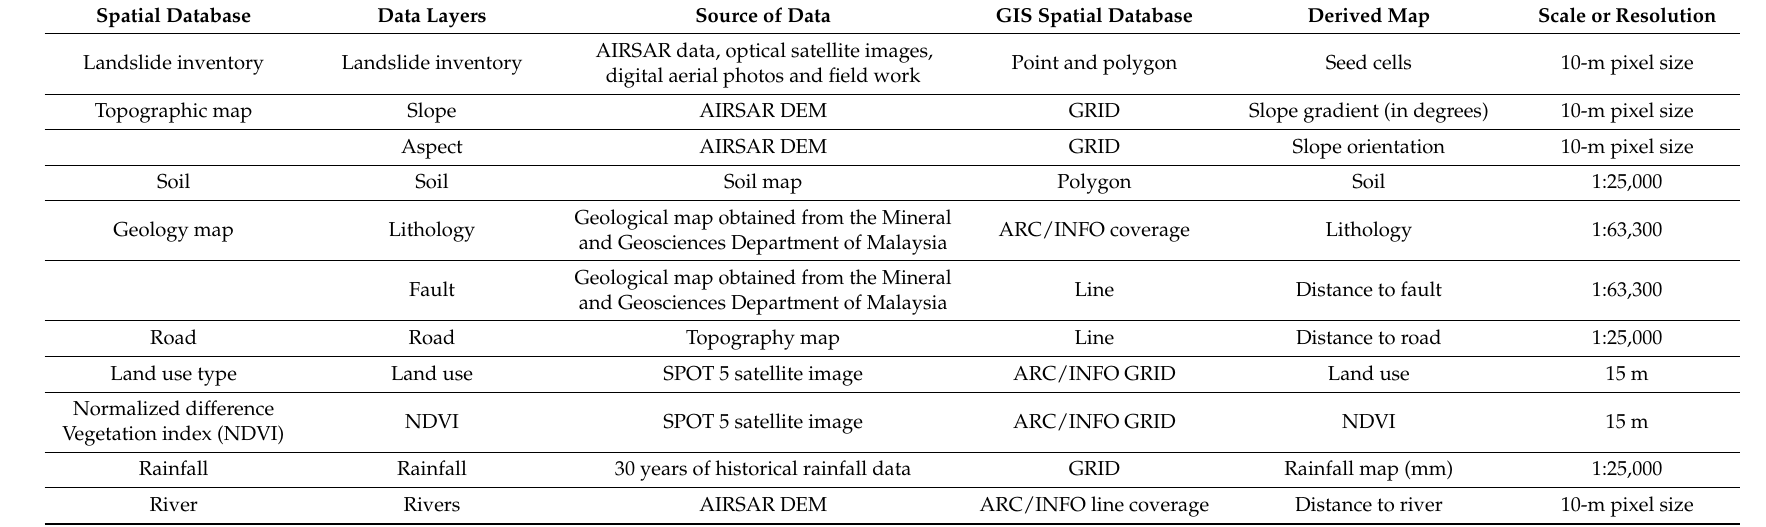
Table 2. Factors used in susceptibility assessment, data sources and associated factor classes for landslide susceptibility mapping in Cameron